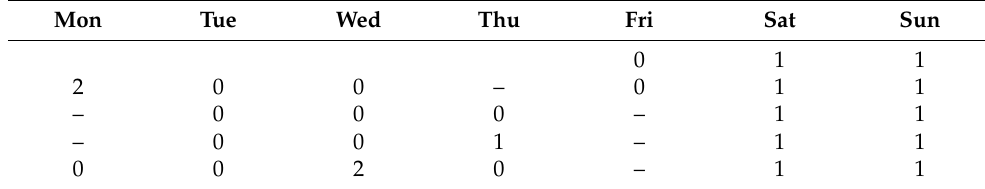
Table 4. Effective clustering results of KPI time series data sub-sequences.